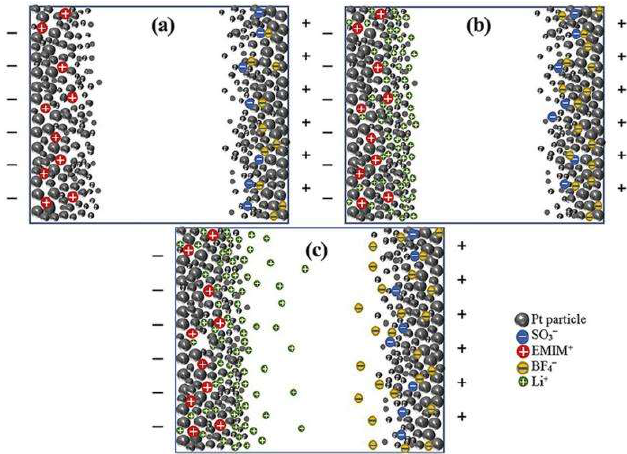
Figure 10. Schematic diagram of IPMC bilayer structures prepared by imidazolium-based ionic liquids with different concentrations. ( a ) Without Li + ions. ( b ) Optimal concentration of Li + ions (0.1 M). ( c ) Higher concentrations of Li + ions (>0.1 M) [48].